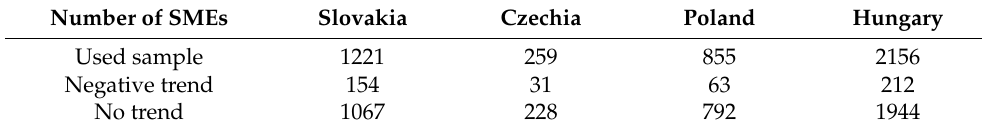
Figure 1. Negative trend in Slovakia. Table 3. Trends of SMEs.